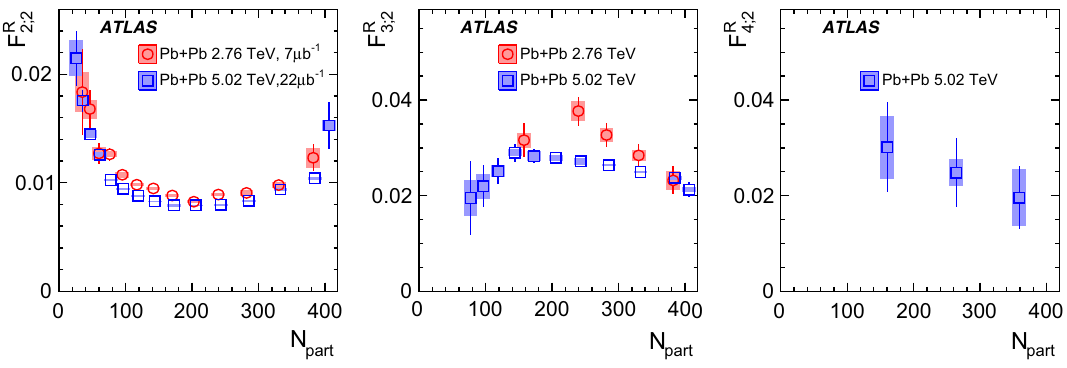
Fig. 12 Centralitydependenceof F R uncertainties, respectively. The widths of the centrality intervals are not (leftpanel), F R (middlepanel) 2 ; 2 3 ; 2 fixed but are optimised to reduce the and F R (right panel) for Pb+Pb at 2.76 TeV (circles) and 5.02 TeV 4 ; 2 (squares). The error bars and shaded boxes are statistical andsystematic